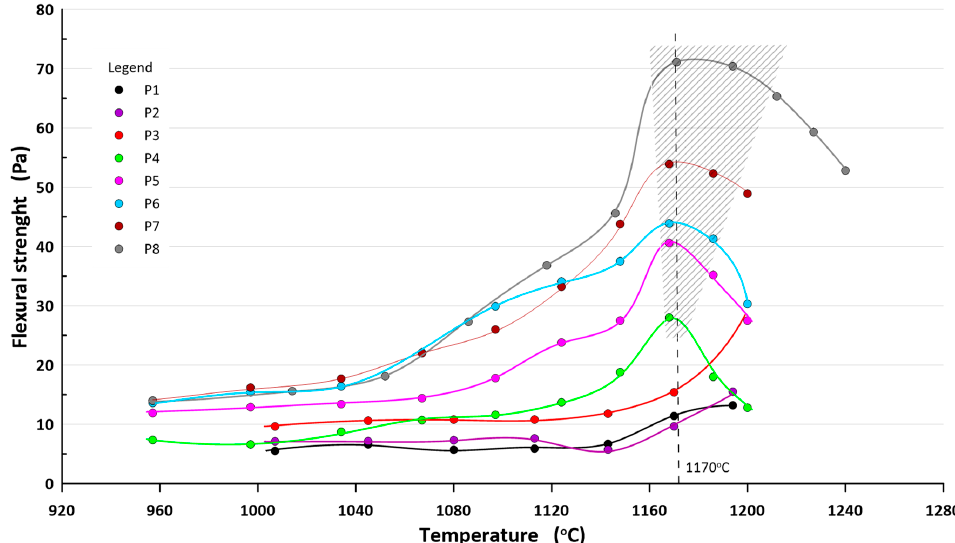
Figure 5. Mechanical bending strength as a function of firing temperature.